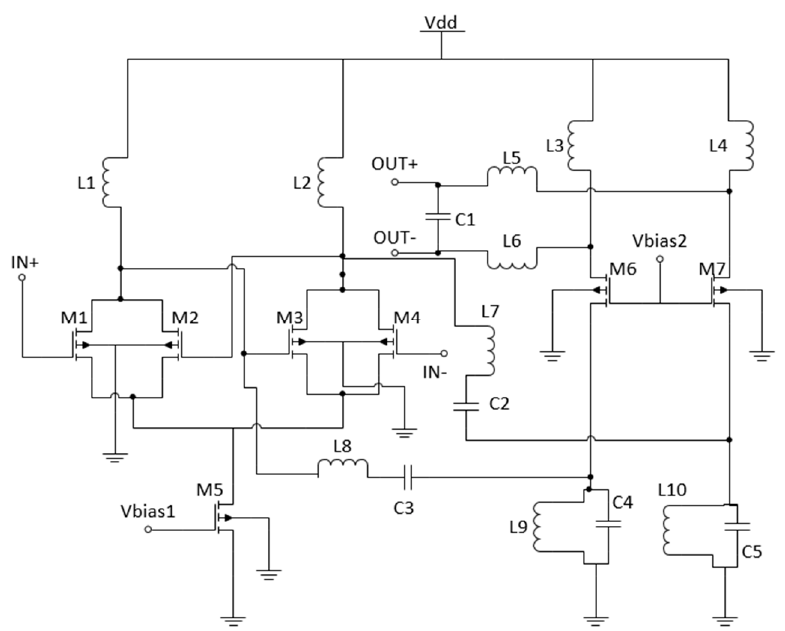
Figure 11. Schematic of proposed differential PA [41].